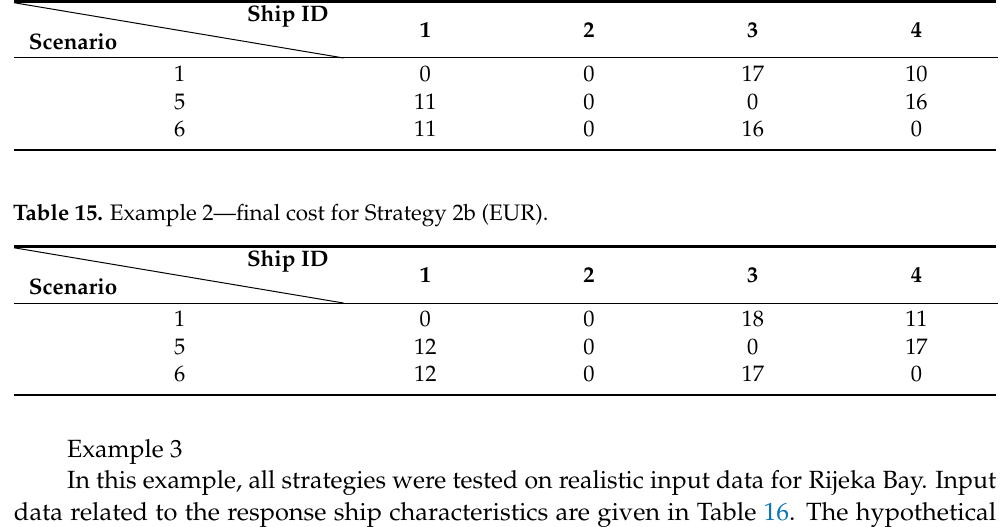
Table 14. Example 2—final duration for Strategy 2b (h).